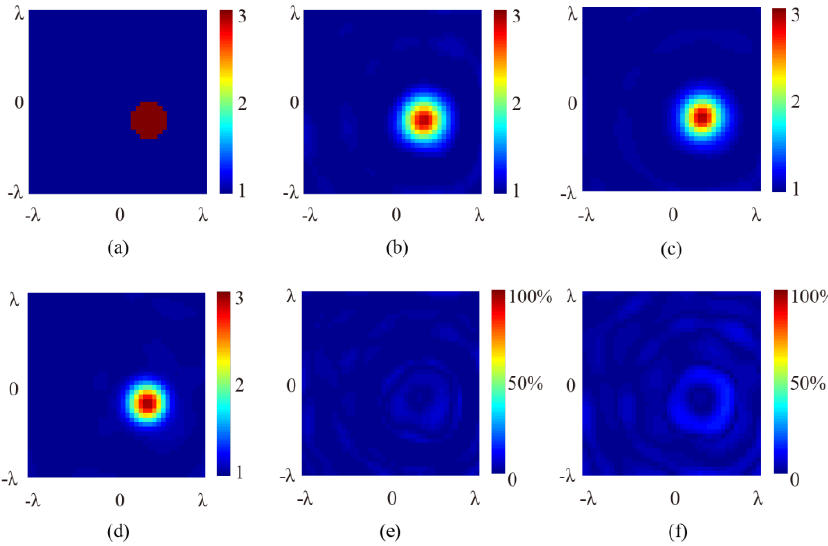
Figure 6. The retrieved cross-section profile of the off-centered 2D cylinder. ( a ) Original profile; ( b ) retrieved result at normal incidence; ( c ) retrieved result at 15° angle of incidence; ( d ) retrieved result at 30° angle of incidence; ( e ) relative error between 6 c and 6b; and ( f ) relative error between 6d and 6b.